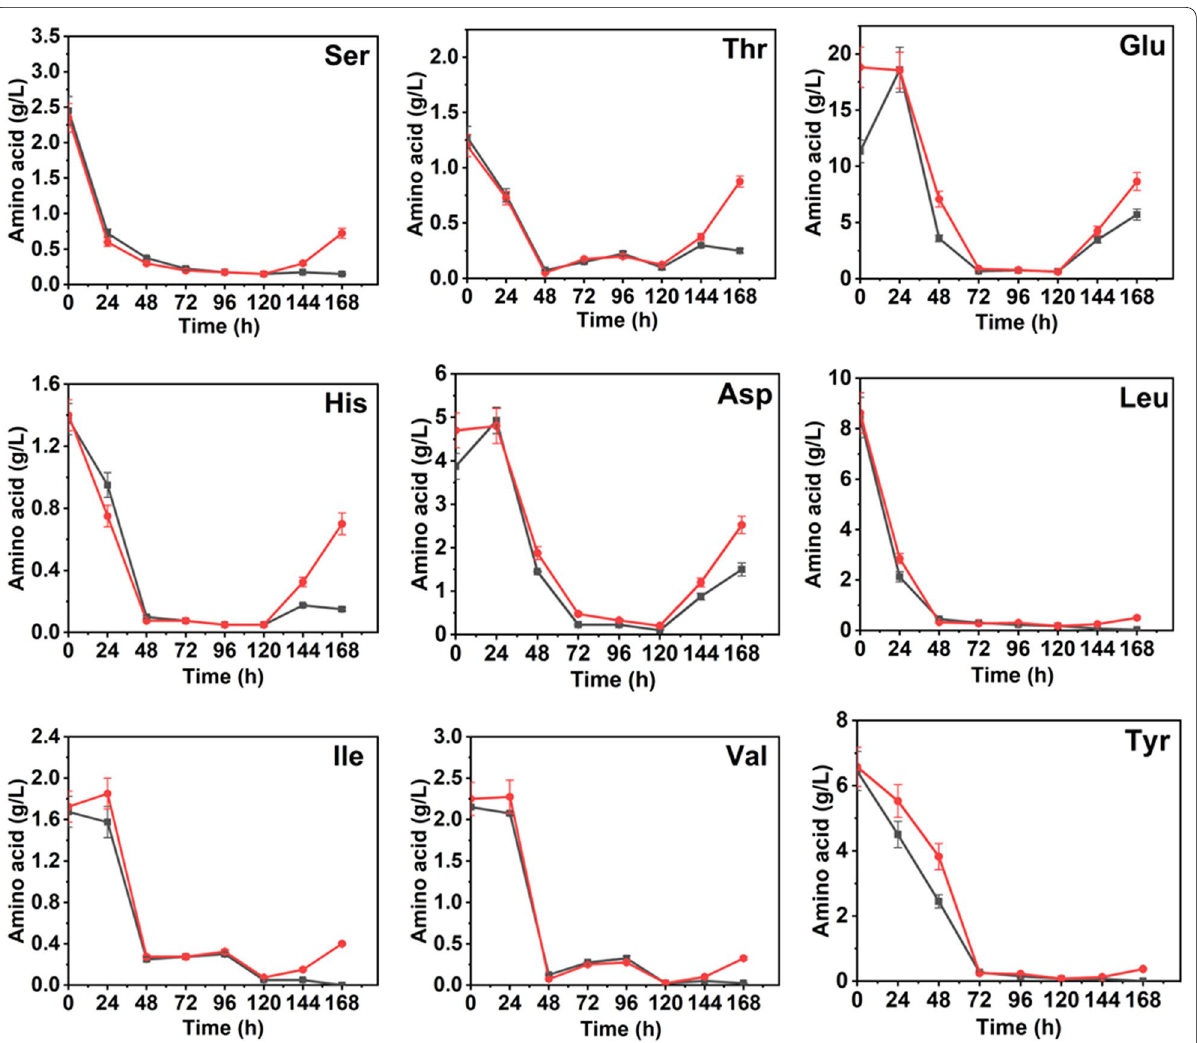
Fig. 5 Profiles of extracellular amino acids during RML fermentation between control group and SLs addition group. Nine representative amino acids including serine, threonine, glutamate, aspartate, histidine, leucine, isoleucine, valine and tyrosine were shown. The control groups were represented by black lines, and the SLs addition groups were represented by red